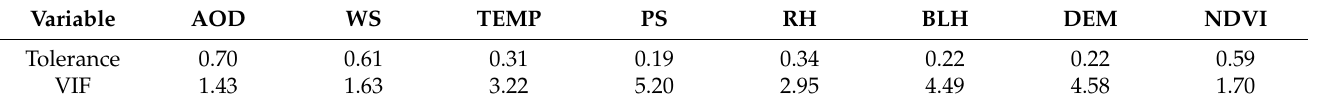
Table 2. The Multi-angle Imaging Spectro-Radiometer analysis of independent